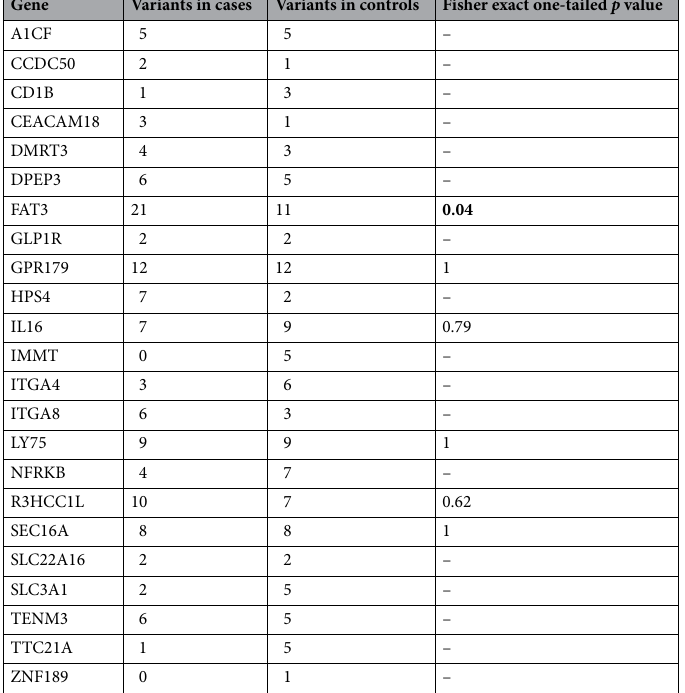
Table 5. Statistical analysis for all selected genes in the replication cohort with potentially protein-altering SNPs with MAF ≤ 1%. Significant values are in